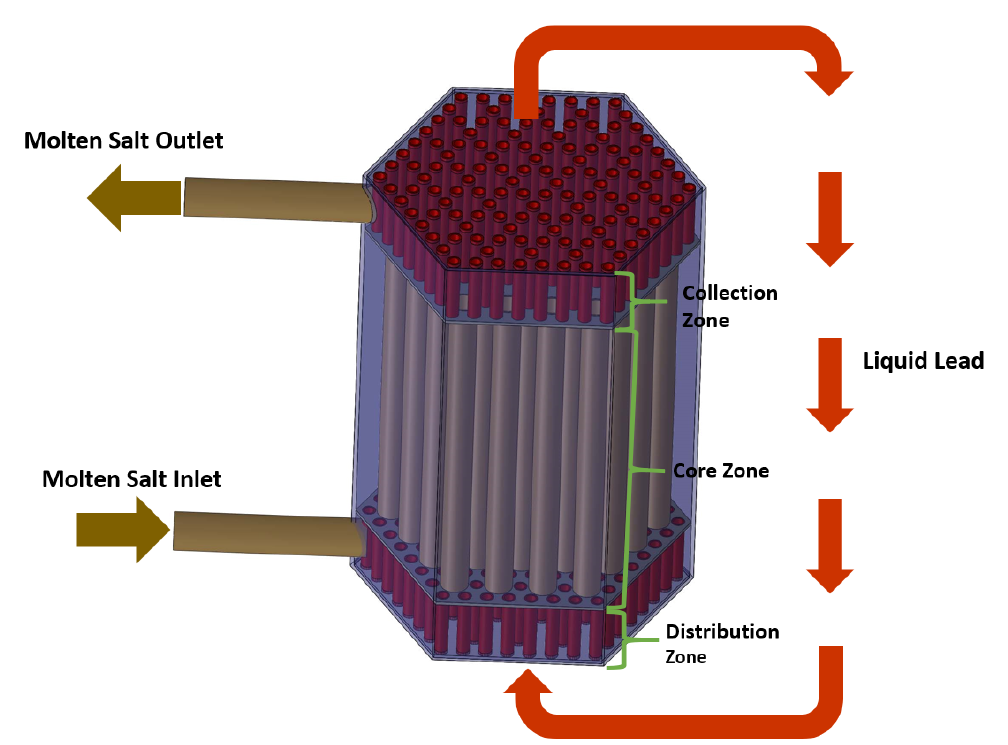
Figure 2. Schematic of the primary circuit (golden) and the secondary ciruit (red) of the Small Modular Dual Fluid Reactor.